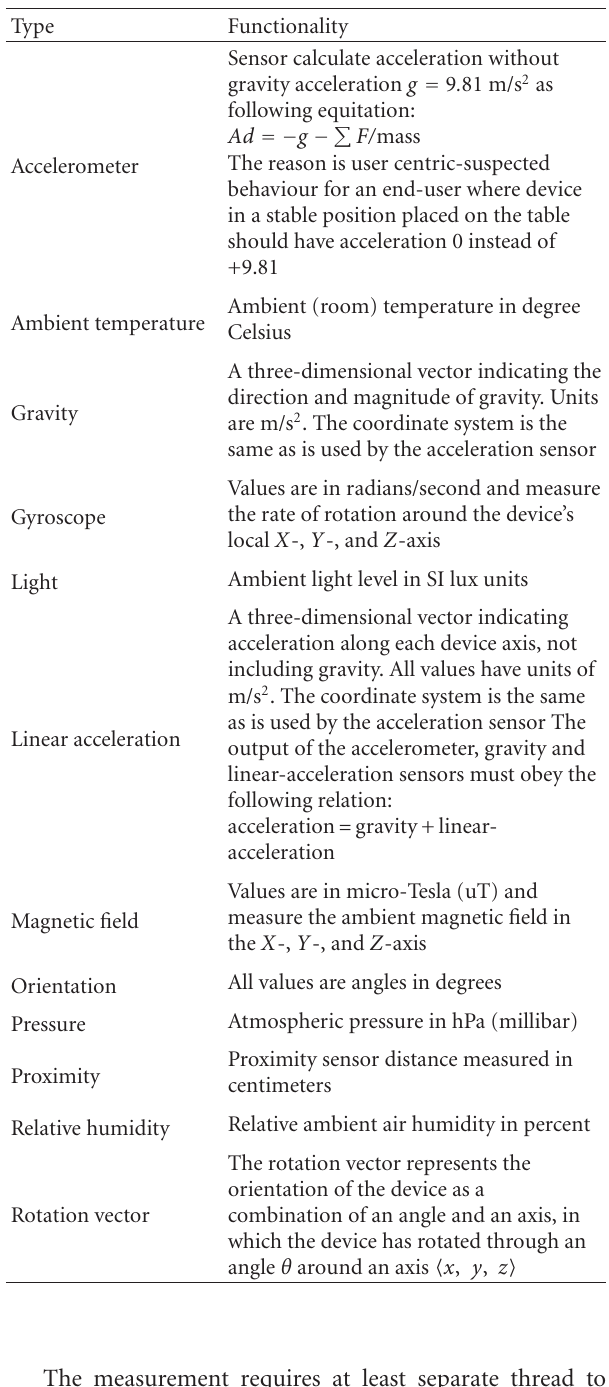
Table 1: Android sensors [18] for smart and ambient environ-